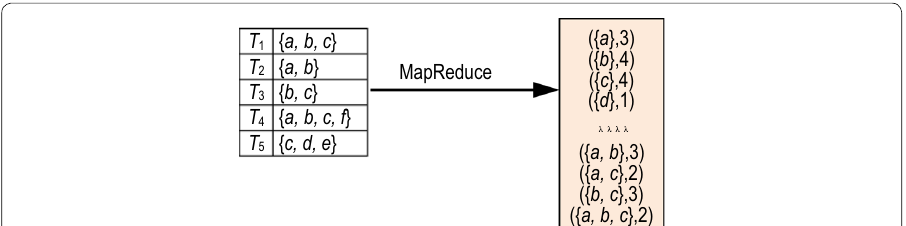
Fig. 7 Execution of AprioriS and results. Illustration of MapReduce execution and results of our